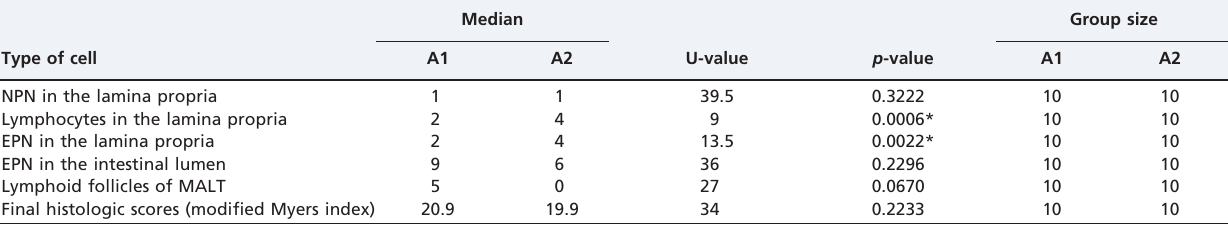
Table 3 - Results of the Mann-Whitney U test for the comparison of histologic scores by cell type and lymphoid follicles between the control group (A1) and prophylactic group treated with short chain fatty acids (SCFAs) (A2).